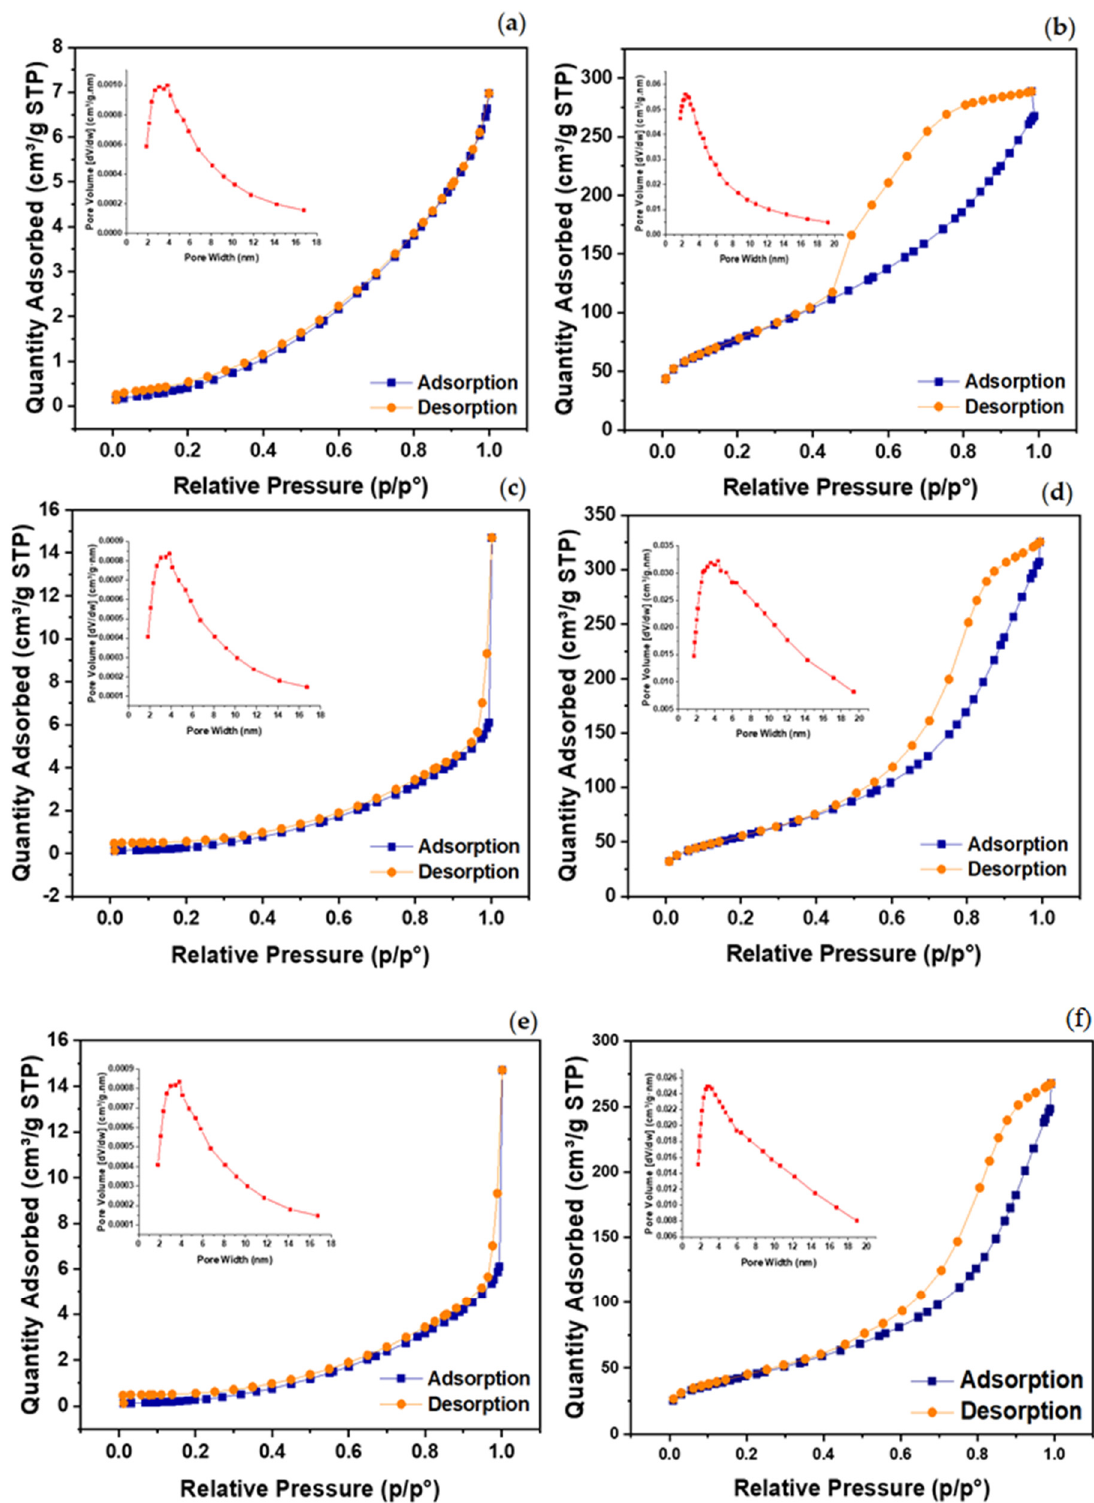
Figure 3. N2 adsorption-desorption equilibrium and BJH pore size distribution of ( a ) powder Al 2 O 3 , ( b ) beads Al 2 O 3 , ( c ) powder KOH/Al 2 O 3 , ( d ) beads KOH/Al 2 O 3 , ( e ) powder K 2 CO 3 /Al 2 O 3 , and ( f ) beads K 2 CO 3 /Al 2 O 3 catalyst.